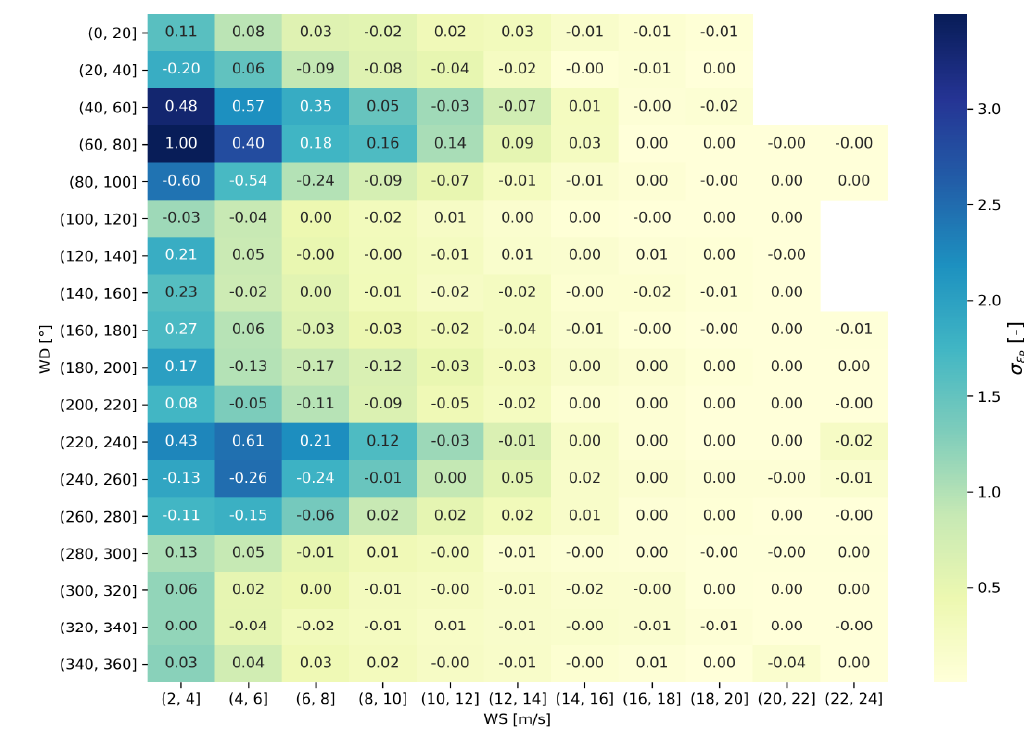
Table 4. Heatmap of the standard deviation (colors) and mean (annotated number) of the relative difference between the stream- line wake model and the baseline model in the calculation of the energy yield of the N6 and N8 cluster. Here, the wind lin- ear superposition was applied. The mean and the standard deviation are computed as µ (cid:15) (cid:115) n (cid:104)(cid:16) (cid:17) (cid:105) 2 (cid:80) 1 − 1 − µ (cid:15) P SWM /P BLM , respectively, with n the last time step of the NEWA time series considered. The wind speed i, N6N8 i, N6N8 n − 1 p i = 0 and direction considered for the bin are taken from the easternmost turbine row of cluster